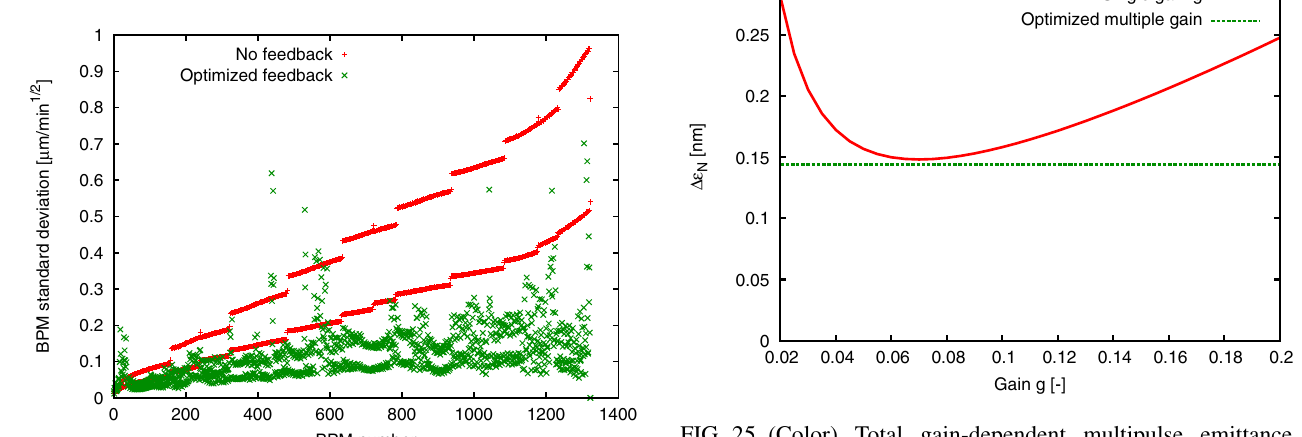
FIG. 25. (Color) Total gain-dependent multipulse emittance growth for various values of the single gain parameters and for the optimal multiple gains (see Fig. 24). For the optimal single (cid:6) gain g (cid:6) 0 : 07 , the multipulse emittance growth is (cid:1) (cid:2) NM (cid:6) 0 : 144 nm for optimized mul- 0 : 148 nm compared to (cid:1) (cid:2) NM tiple gain